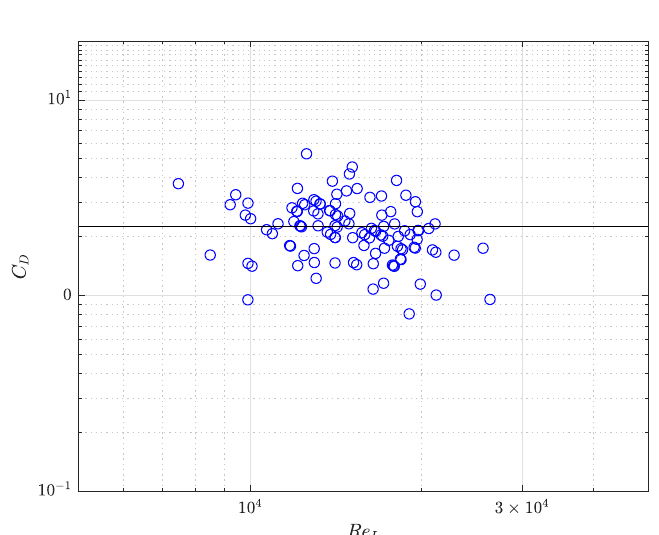
Figure 13. Drag coefficient as a function of Reynolds number Re L for Asterias rubens . The solid line corresponds to